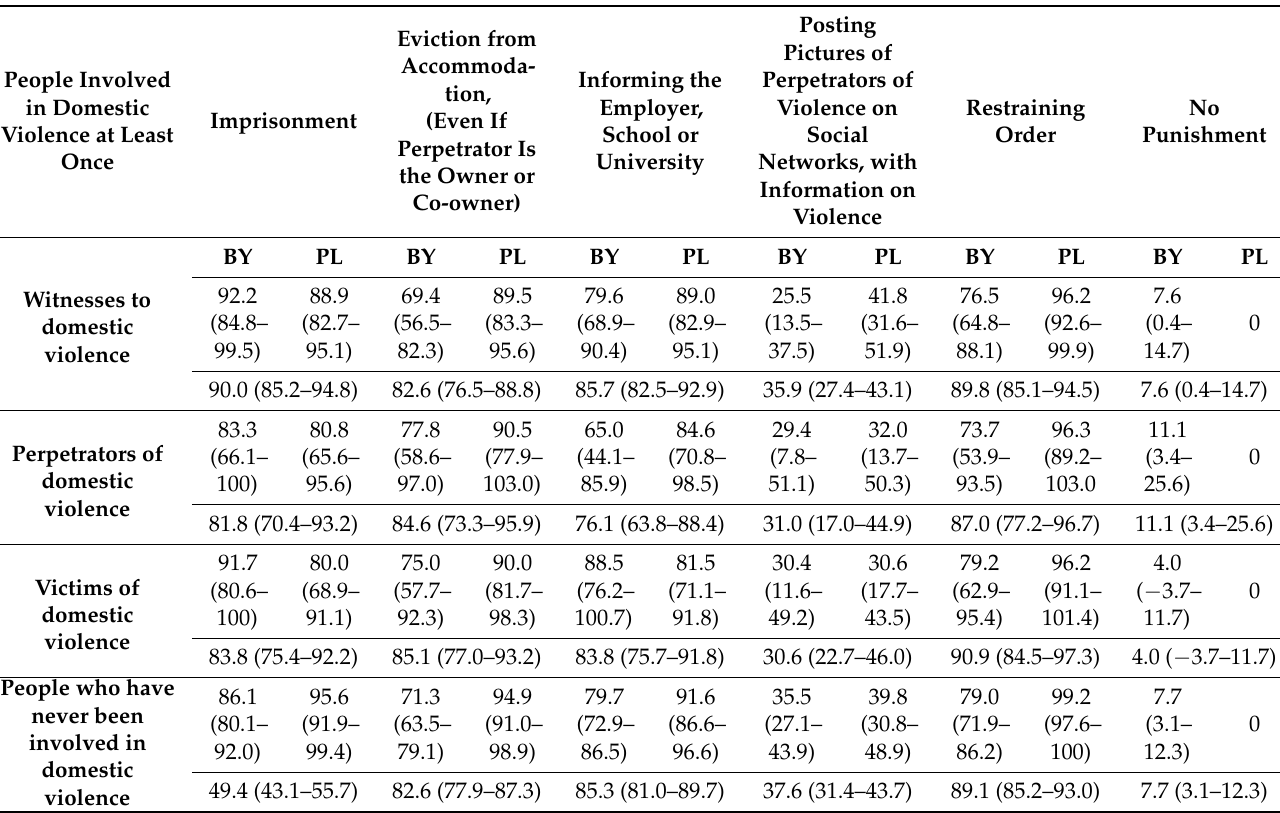
Table 2. The relationship between the form of involvement in domestic violence and the type of